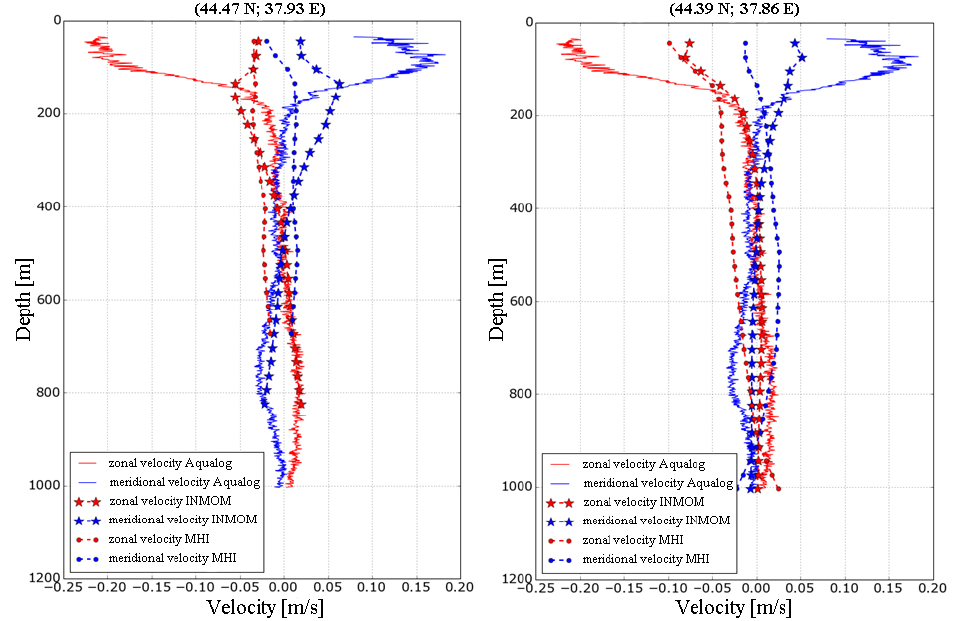
Figure 5. Vertical profiles of the zonal and meridional velocity components according to the Aqualog data, the MHI, and INMOM models on June 16, 2011: ( a ) at (44.47 ◦ N, 37.93 ◦ E), ( b ) at (44.39 ◦ N, 37.86 ◦